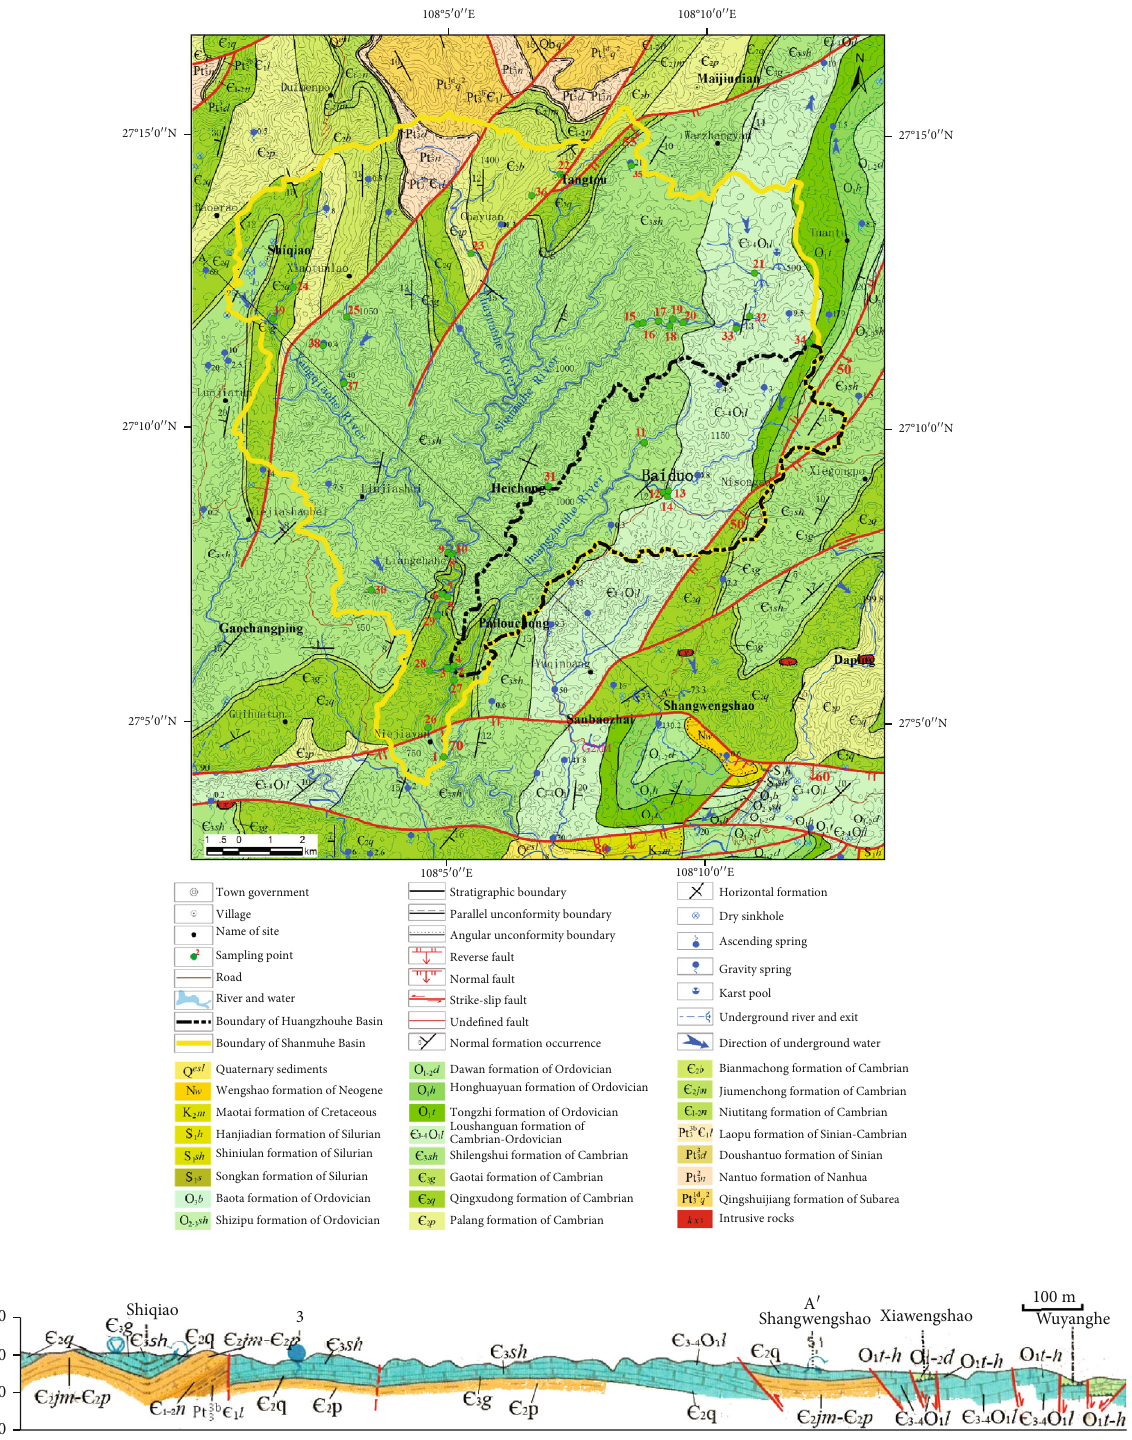
Figure 1: Distribution of water sampling points collected in the study area and the hydrogeological pro fi le of the Oujiayuan A to Shangwengshao A ′ section (modi fi ed after